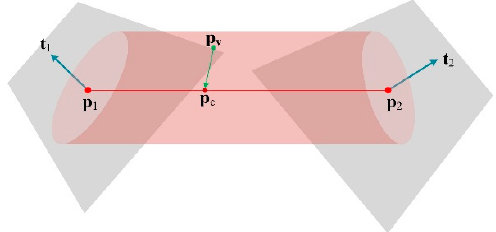
p ; t 1 and t 2 are the tangents 1 2